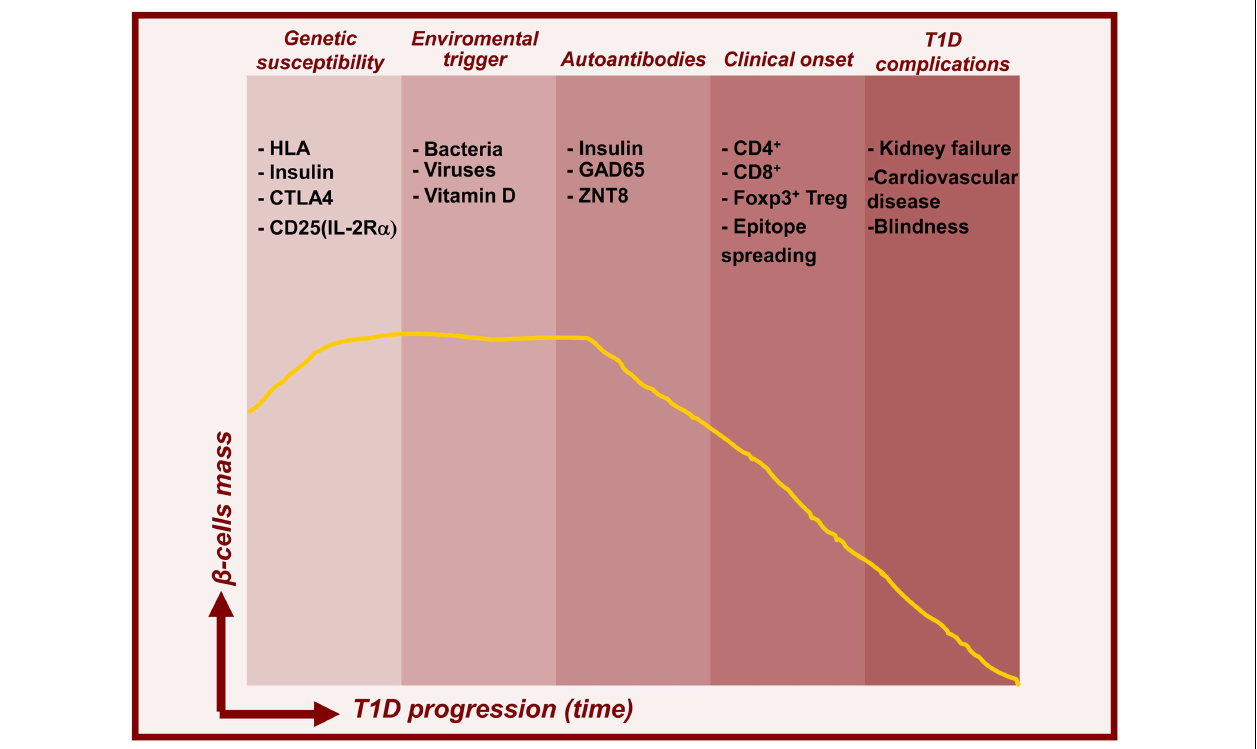
FIGURE 1 |Timelines for type 1 diabetes . Model for temporal relationship between beta-cell mass decline and features ofT1D pathogenesis. In addition to genetic predisposition, environmental triggers induce islet autoimmunity and beta-cell death leading to prediabetes and subsequent clinical onset and